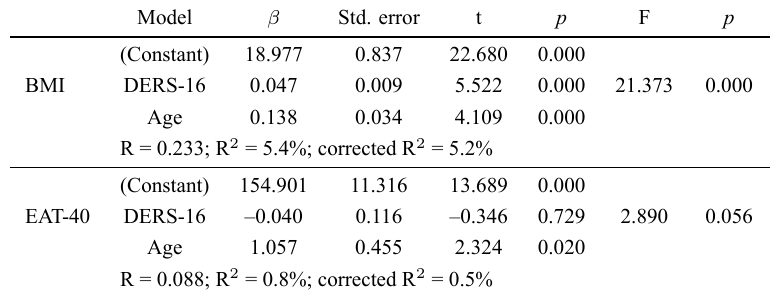
Table 5. Effect of students’ DERS-16 scores and ages on BMI values and EAT-40